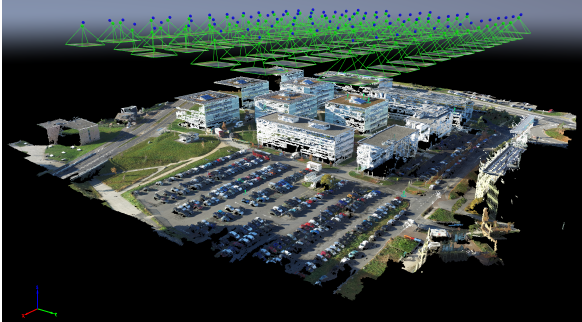
Figure 1: Screenshot of the Pix4Dmapper reconstruction of our test site for a dataset recorded with a DJI Inspire